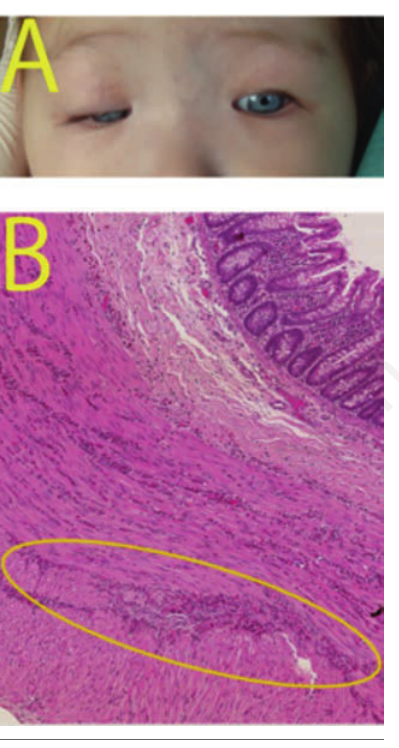
Figure 1. The patient’s characteristic find- ings before open Soave procedure. A) The patient’s facial features. She has bilateral defects of iridial pigment. B) The patho- logical biopsy findings at the sigmoid colon on 5 months old (the circle is the Figure 3. A-B) The pathological findings of the resected specimen at the rectum (the thin point of eosinophil aggregation). The arrows are submucosal ganglion cells). The myenteric plexus does not have ganglion cells. eosinophils had aggregated in the myen- Eosinophil aggregation is not found (A: Hematoxylin & eosin stain, magnification: 4×. B: teric layer (Hematoxylin & eosin stain, Synaptophysin stain, magnification: magnification: 10×).